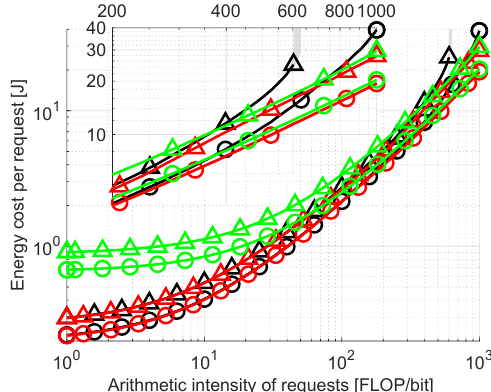
Figure 8. Comparison of energy consumption per request with varied arithmetic intensity. Same legend as in Figures 4 and